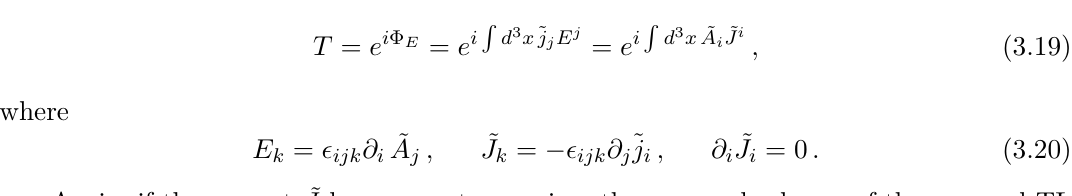
Figure 2. The support of J ( x ) and